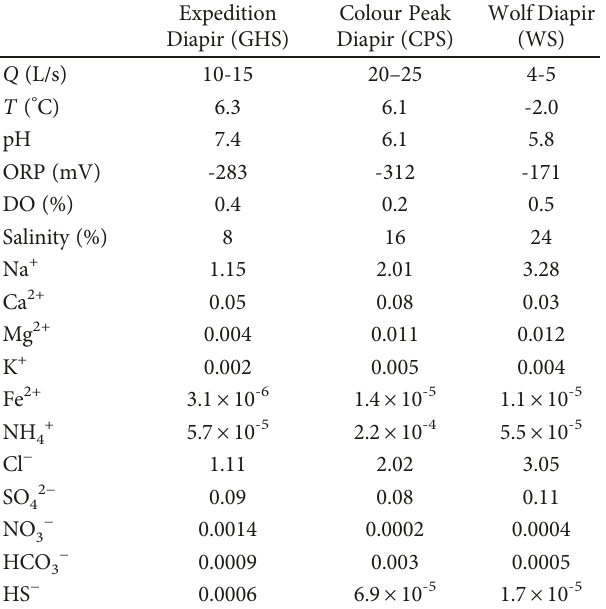
Table 2: Summary data of the major geochemical parameters of waters collected from spring out fl ows (Gypsum Hill Springs, Colour Peak Springs, and Wolf Springs) and associated hydrologic measurements. Given that numerous spring outlets exist at Expedition Diapir and Colour Peak Diapir, geochemical data shown here represent the average of previously reported results. Concentrations of cations and anions are expressed in mol/kg.